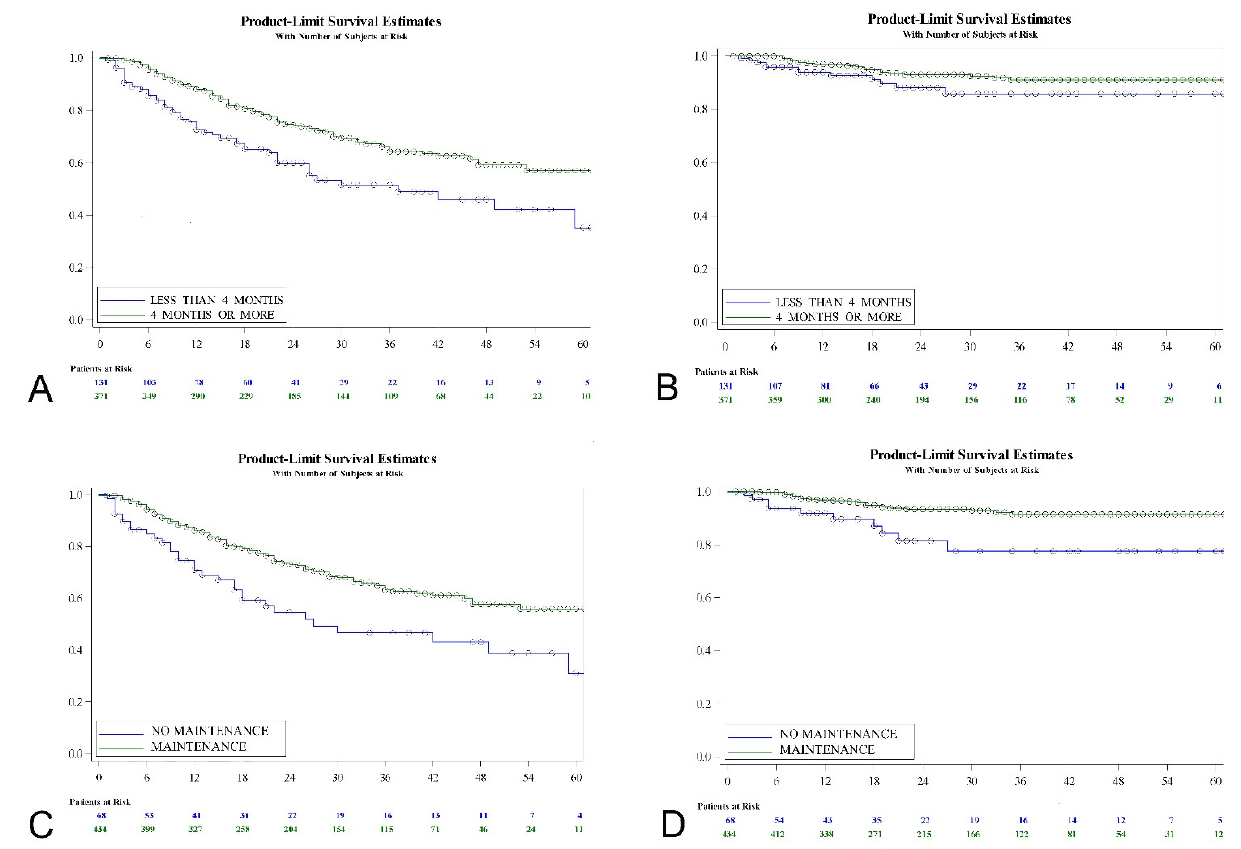
Figure 3. Recurrence ( A ) and progression-free survival ( B ) according to duration of adjunct HIVEC MMC treatment; recurrence ( C ) and progression-free survival ( D ) according to whether maintenance schedule was used. Table 3. Cox regression model to predict tumor recurrence, FAS population ( n = variable as obtained in the univariate analysis. The risk-group, T category, grade, cis, tu- mor history, duration of treatment, use of maintenance therapy, former use of MMC and